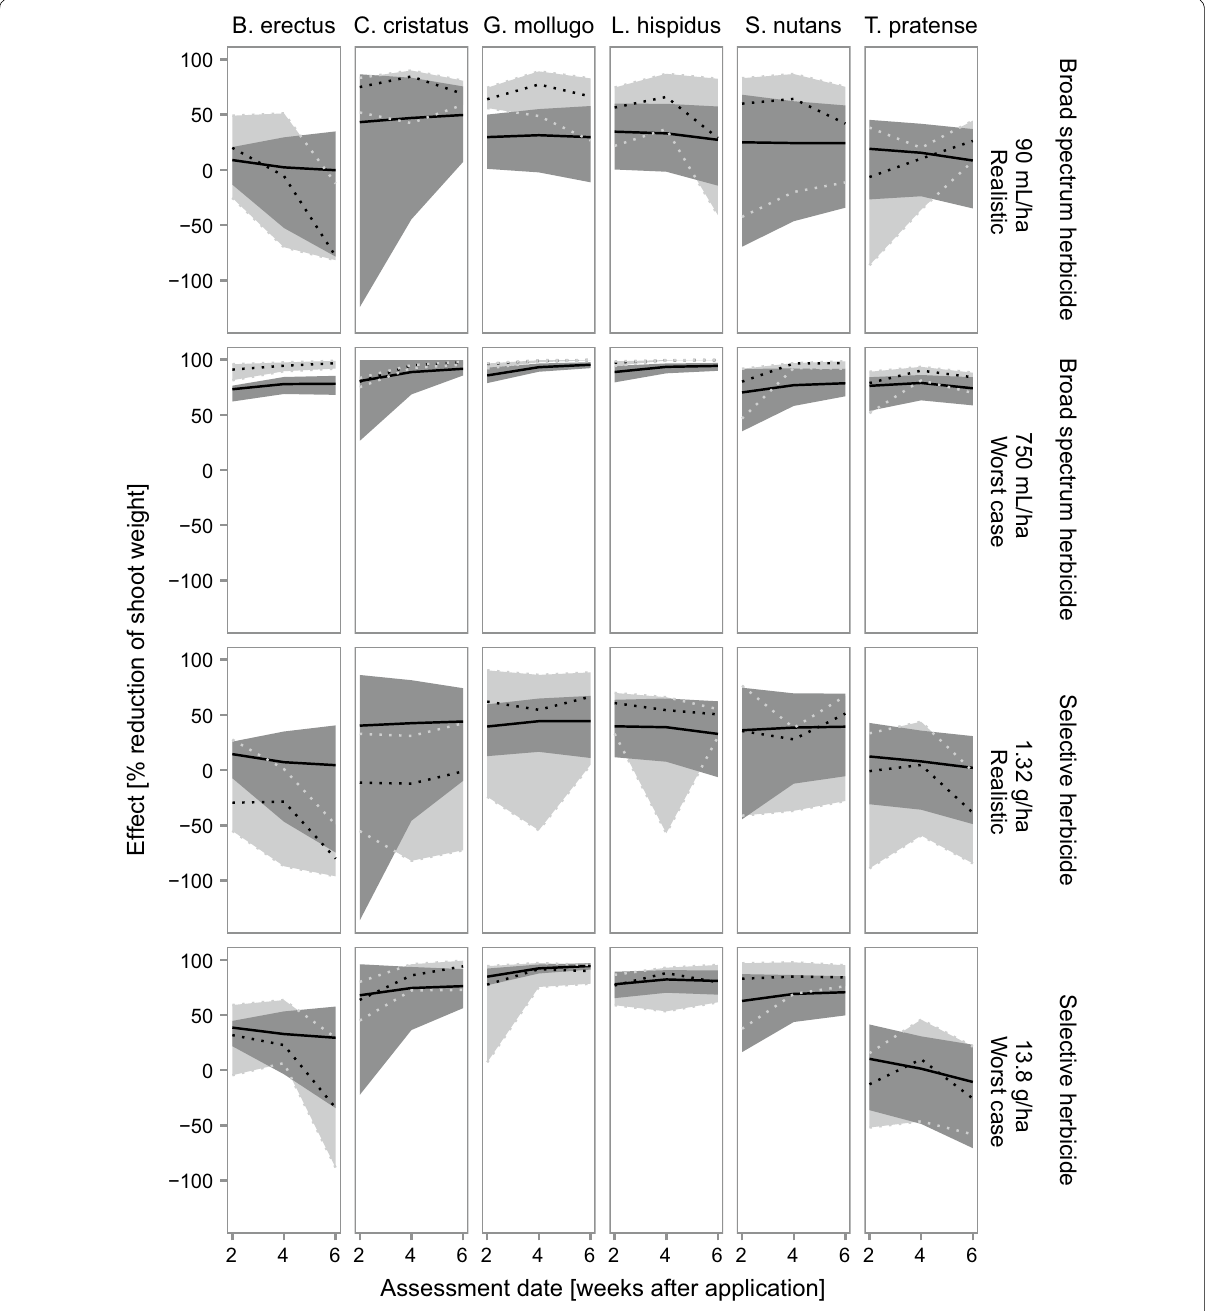
Fig. 6 Effects on species specific shoot masses (treatment/control) in the artificial communities after herbicide application. Black solid lines represent the median of the model predictions and dark gray ribbons show the upper and lower 2.5th percentile of the predictions. Dotted black lines show the empirically measured median and gray ribbons and dotted gray lines the upper and lower 2.5th percentile of these. Only the lowest (realistic) and highest (worst-case) tested application rates are presented here. The lowest rates tested were in the same range (broad spectrum herbicide RoundUp ® ) or higher (selective herbicide Monitor ® ) than the rates that would be applicable to the risk assessment considering European standard drift rates. The results for these test rates are presented to deliver a more realistic picture. Results for the whole range of tested application rates can be found in Additional file 1: Appendix